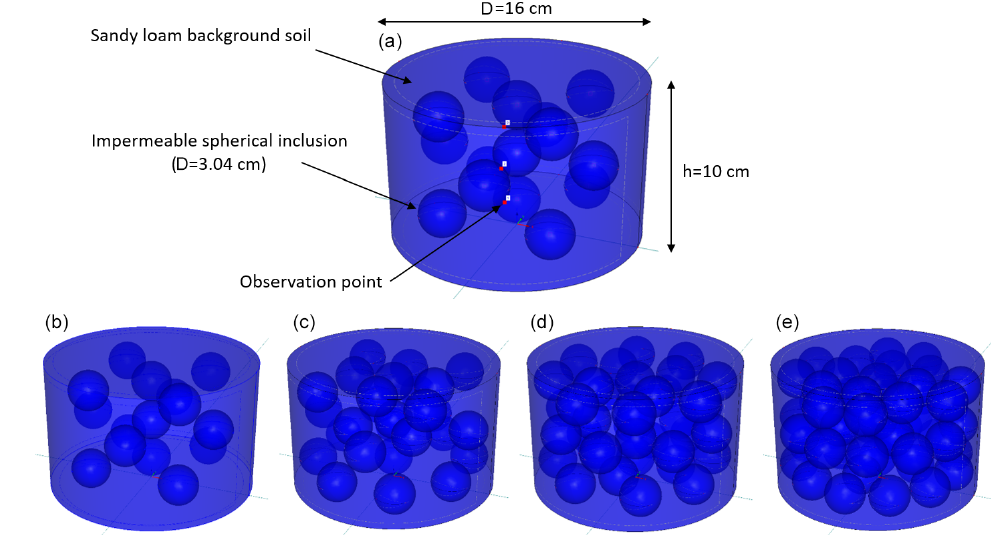
Figure 1. Visualization of the generated stony soils in 3D, including the dimension of the RFs and the soil cylinder as well as the location of the observation points (a) . The bottom row shows the RF contents of 11.0% (b) , 19.8% (c) , 28.5% (d) , and 37.3% (e) , from left to